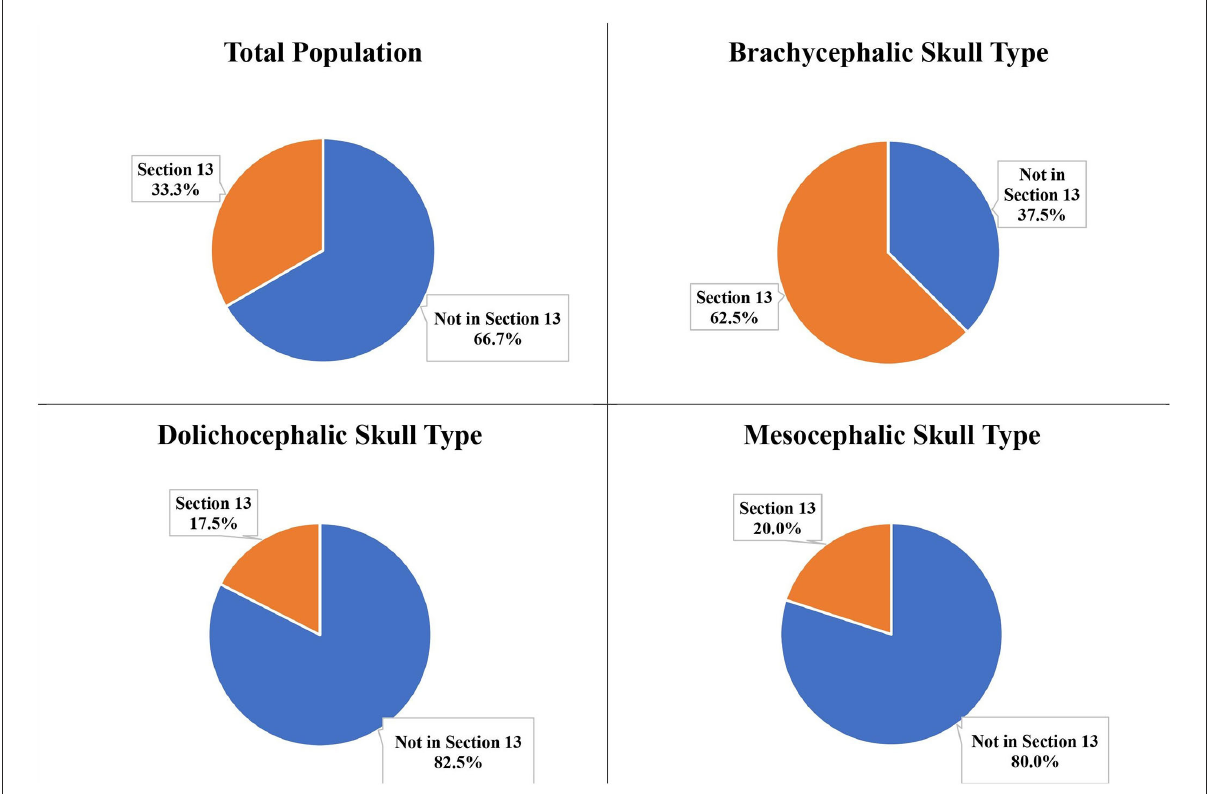
FIGURE12 Section 13 relative to the distal roots of the P4 for the total population and the three different skull types.